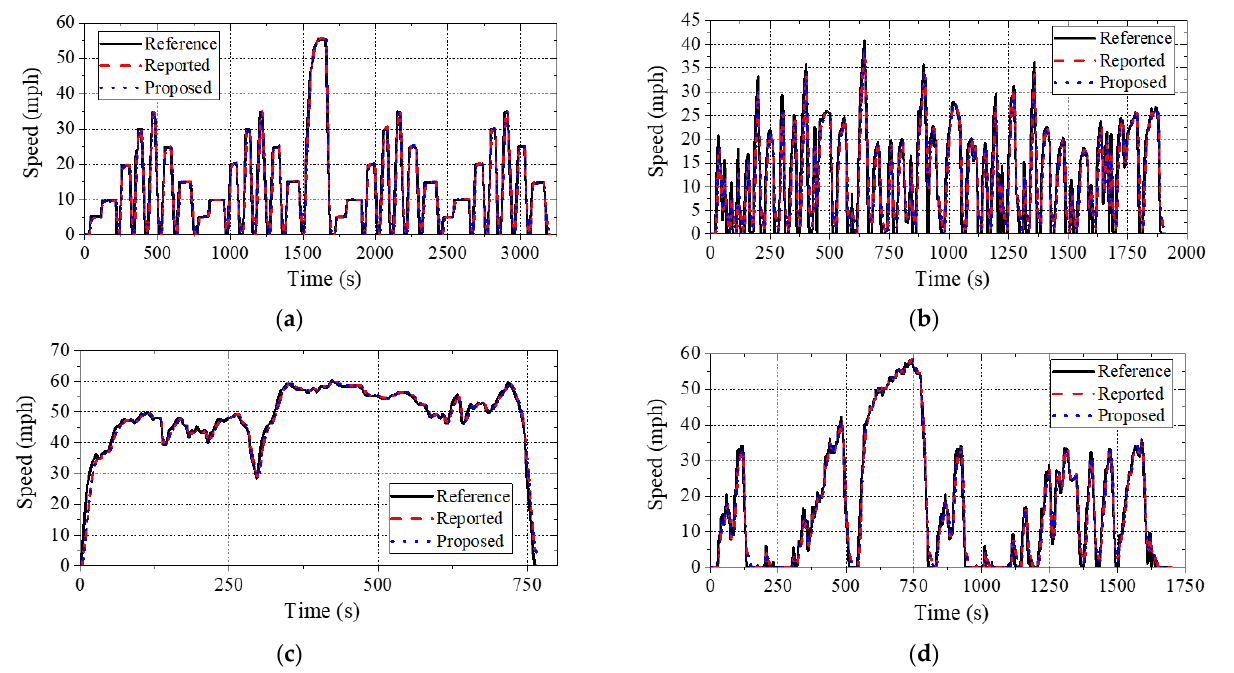
Figure 23. Tracking performance of the reported and proposed motor under ( a ) CILCC, ( b ) OCC, ( c ) HWFET, and ( d )